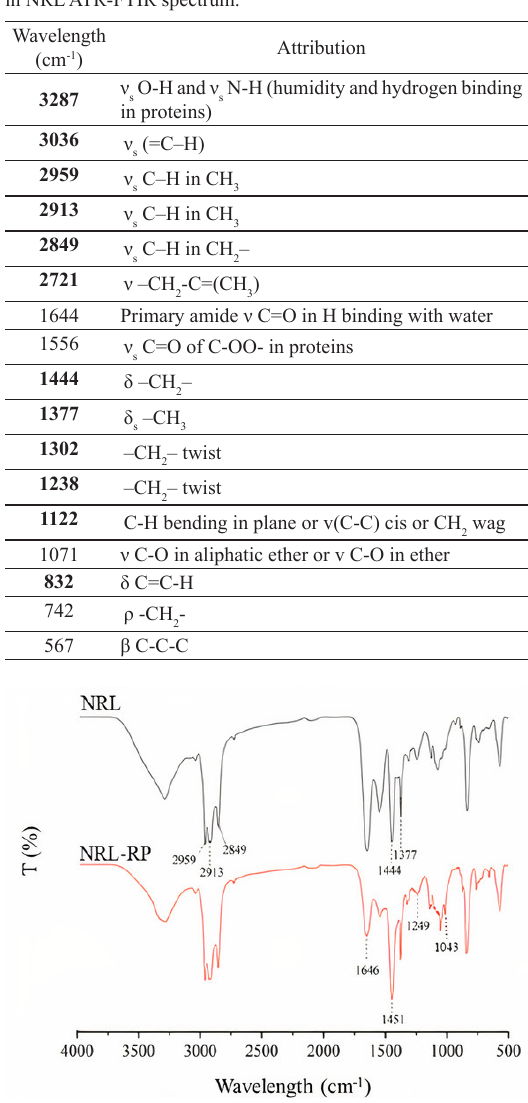
Figure 2. ATR-FTIR spectra of NRL and